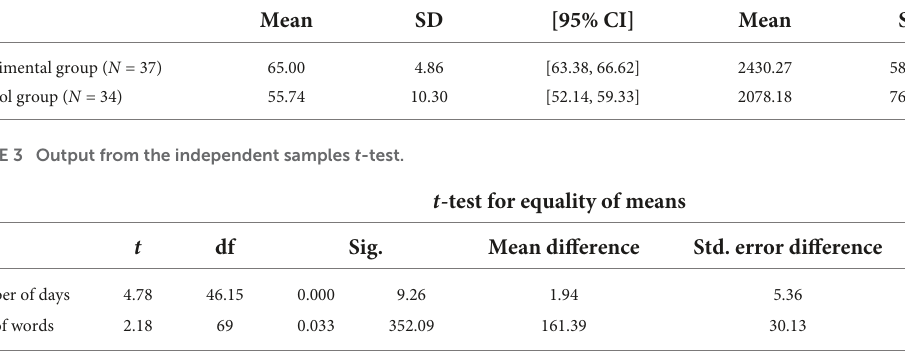
TABLE 4 Factorial ANOVA output: Effects of self-regulation and peer scaffolding on the number of days. Source